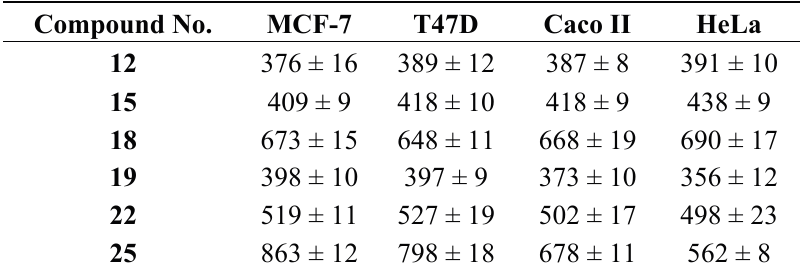
Table 2. The LD 50 values (ng/ μ L) of the examined compounds on four human cancer cell lines . Values are expressed as mean ± SD of three experiments. Compound